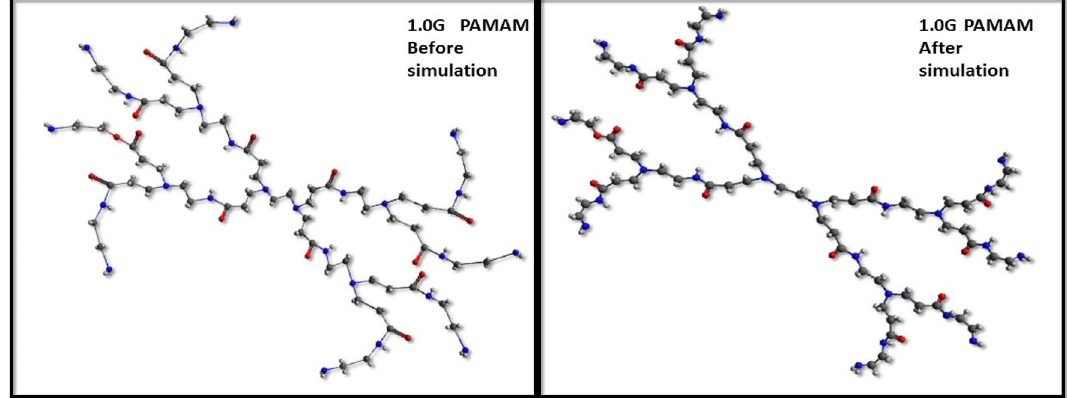
Figure 1. Illustrations showing parameterized simulations on 1.0G PAMAM (Avogadro 1.1.1, http://avoga dro.